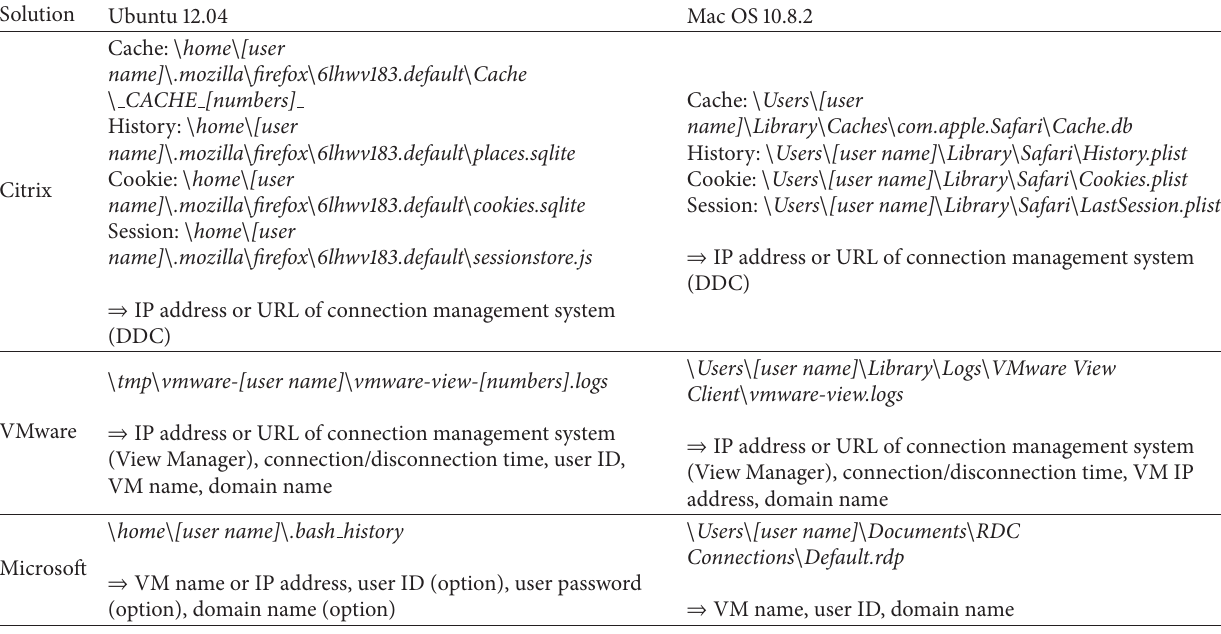
Table 4: Access information logged in local Ubuntu and Mac systems.